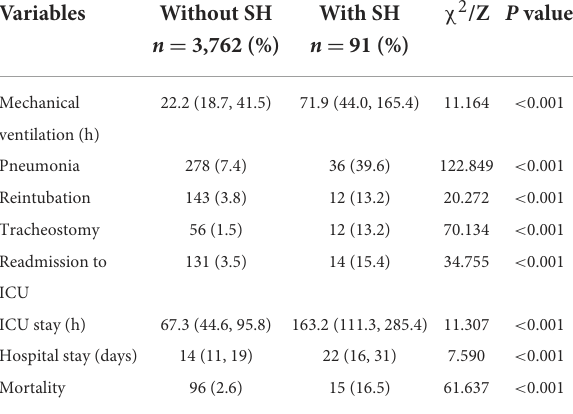
TABLE 4 Postoperative variables in patients with and without SH following